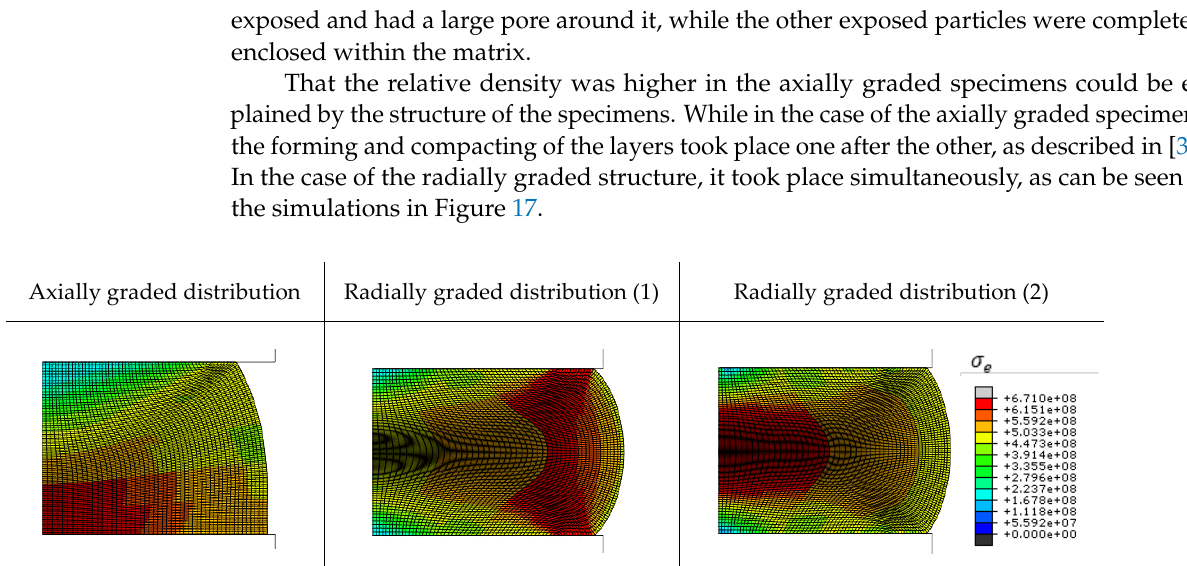
Figure 17. Simulation of the forming of the specific graded structures. It can be seen that with the same strain, individual layers of the axially